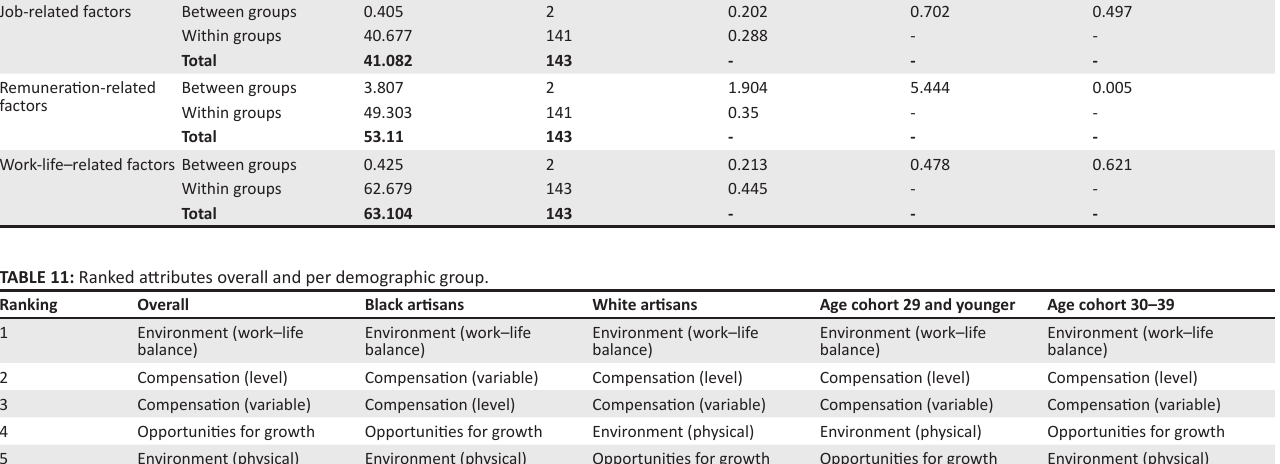
TABLE 10: Analysis of variance: Age cohorts. Factors Groups Job-related factors